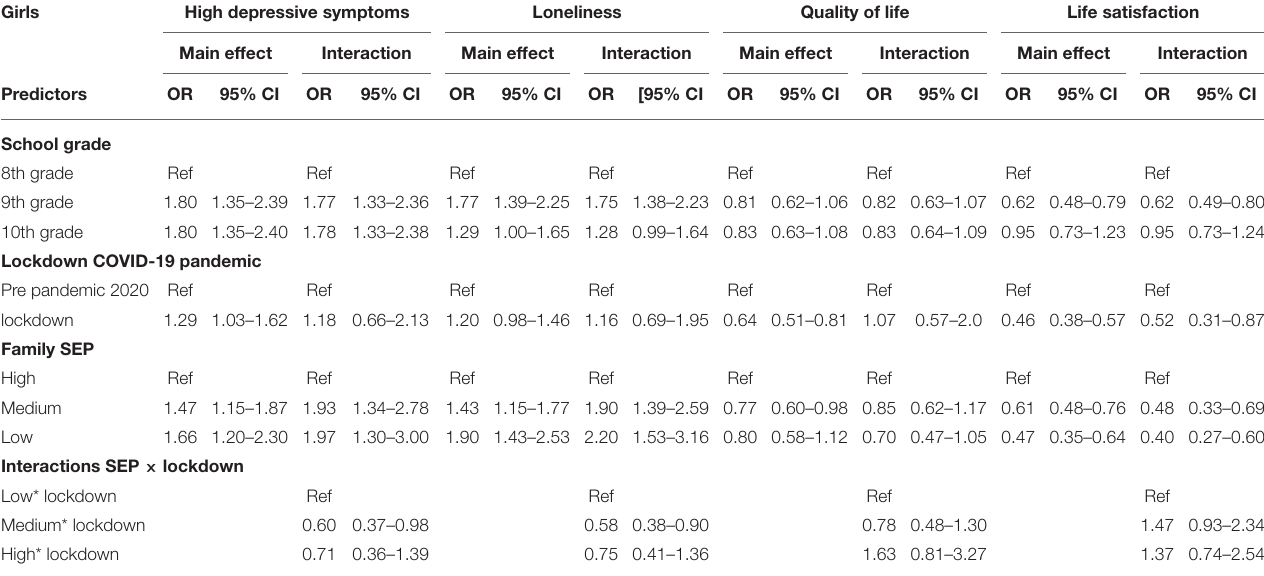
TABLE 3 | The impact of family SEP and lockdown during COVID-19 pandemic * , and its interaction on the probability of high level of depressive symptoms, loneliness, quality of life, and life satisfaction among girls in lower secondary education. Girls